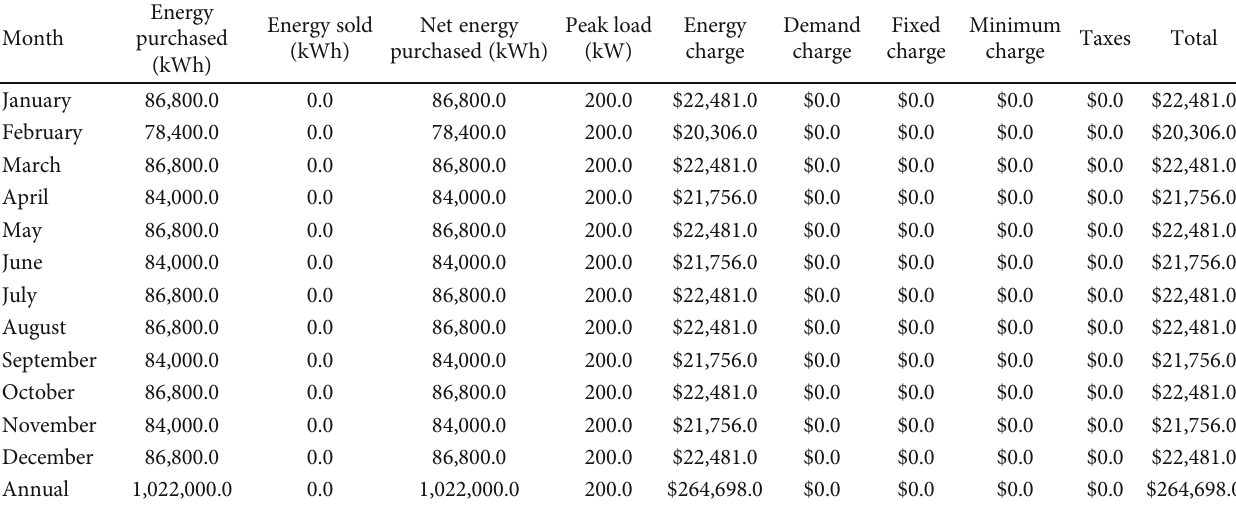
Table 27: Utility monthly summary — current system (Rwanda).